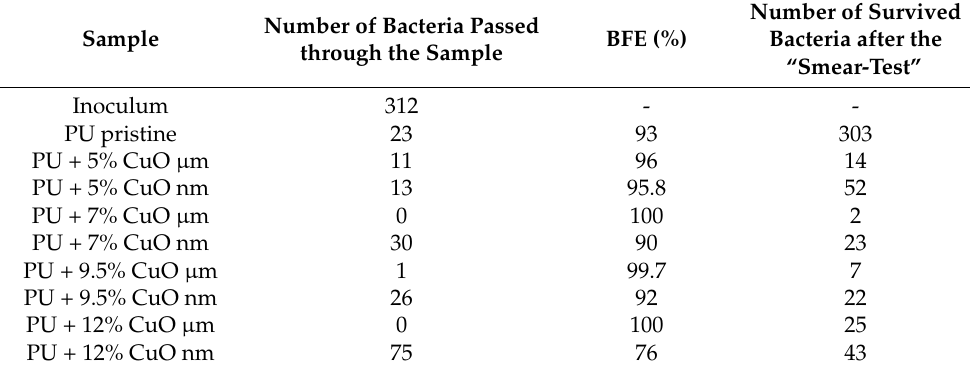
Table 7. Results of the bacterial filtration test and “smear-test” for samples produced from the wire